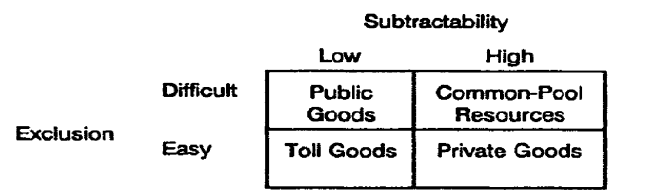
Fig. 7. General classification of goods (Ostrom, et al., 1994, p.